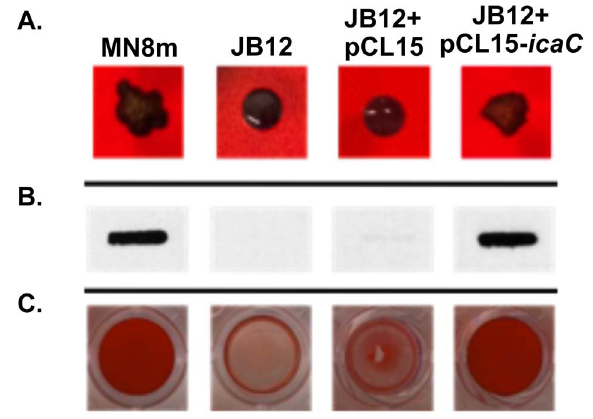
Figure 4. Effect of complementation of JB12 with icaC in trans on colony morphology, PNAG production, and biofilm forma- tion. A. Colony morphology of labeled S. aureus strains on Congo red agar (CRA) plates. B. PNAG slot blot of cell surface fractions probed with polyclonal anti-PNAG antiserum (MN8m and JB12 + pCL15- icaC samples were diluted 1:100 prior to immobilization on membrane whereas JB12 and JB12 + pCL15 were not diluted). C. Biofilms formed on microtiter plate wells were stained with safranin and the safranin was quantified by resuspending in acetic acid and measuring OD 562 nm . Bars represent the mean OD 562 nm of 6 replicates, and error bars indicate the standard deviations. Statistical comparison (unpaired t test) of JB12 + pCL15 (empty vector) versus JB12 + pCL15- icaC gave a P value of ,